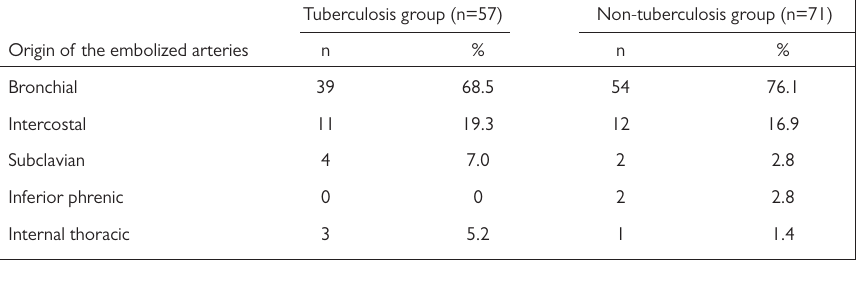
Table 3. Number of embolized arteries and origins of the pathologic artery in tuberculosis and non-tuberculosis group